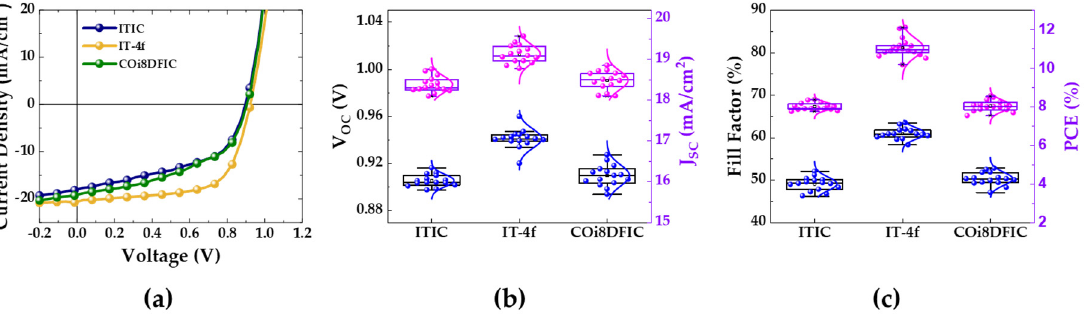
Figure 1. Schematic illustration of the molecular structure of the selected electron transport materials (ETMs) and the device architecture of the inverted, planar, non ‐ fullerene perovskite solar cells (PSC).